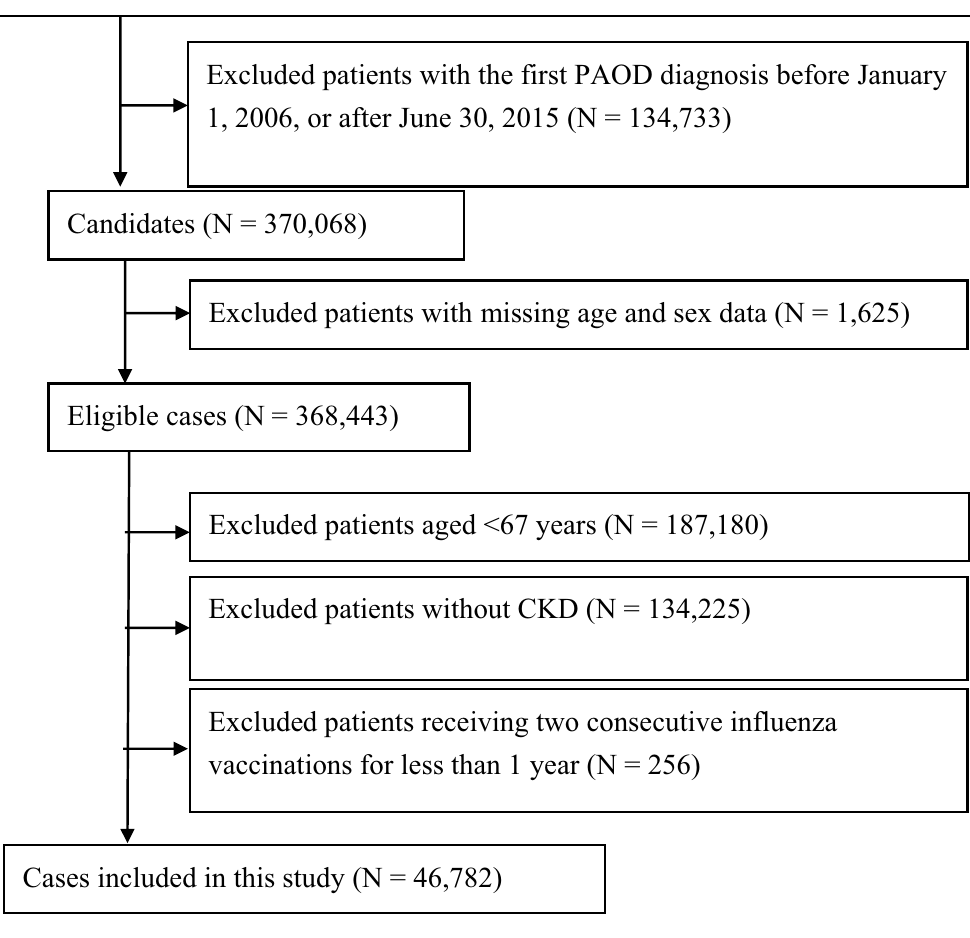
Figure 1. Flowchart of the selection criteria and process for eligible patients with CKD and PAOD. CKD chronic kidney disease, PAOD peripheral arterial occlusive